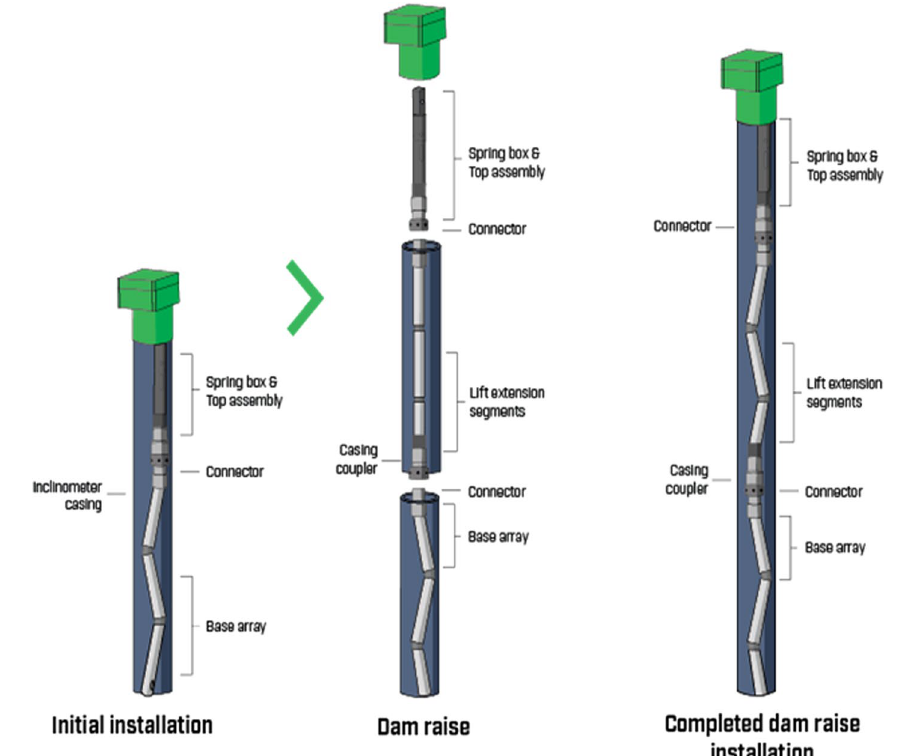
Fig. 6 Inclinometer probe extension technology (manufacturer’s website—measurand.com)